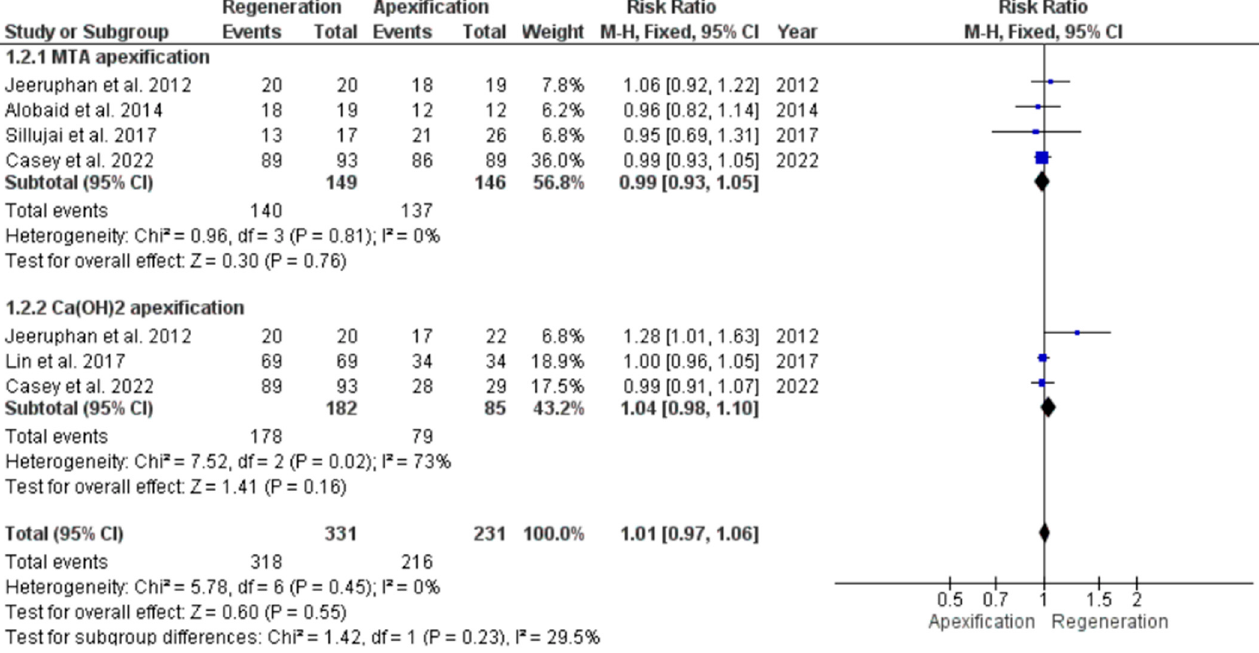
Figure 9. Meta-analysis of survival rate of young immature permanent teeth that underwent regenerative endodontic procedure (REP) or apexification procedure.